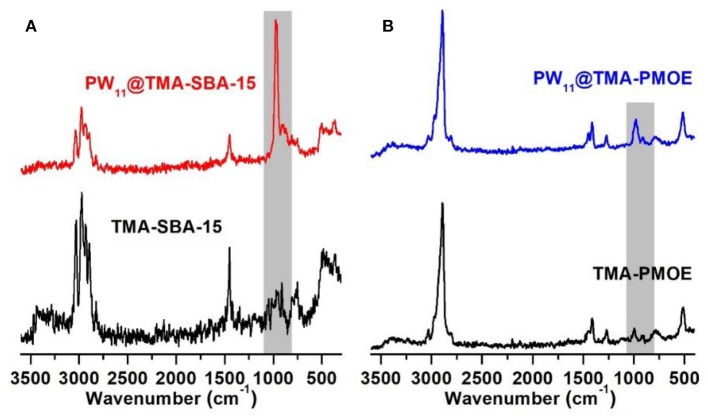
FT-Raman spectra of (A) TMA-SBA-15 and (B) TMA-PMOE composites with PW11.